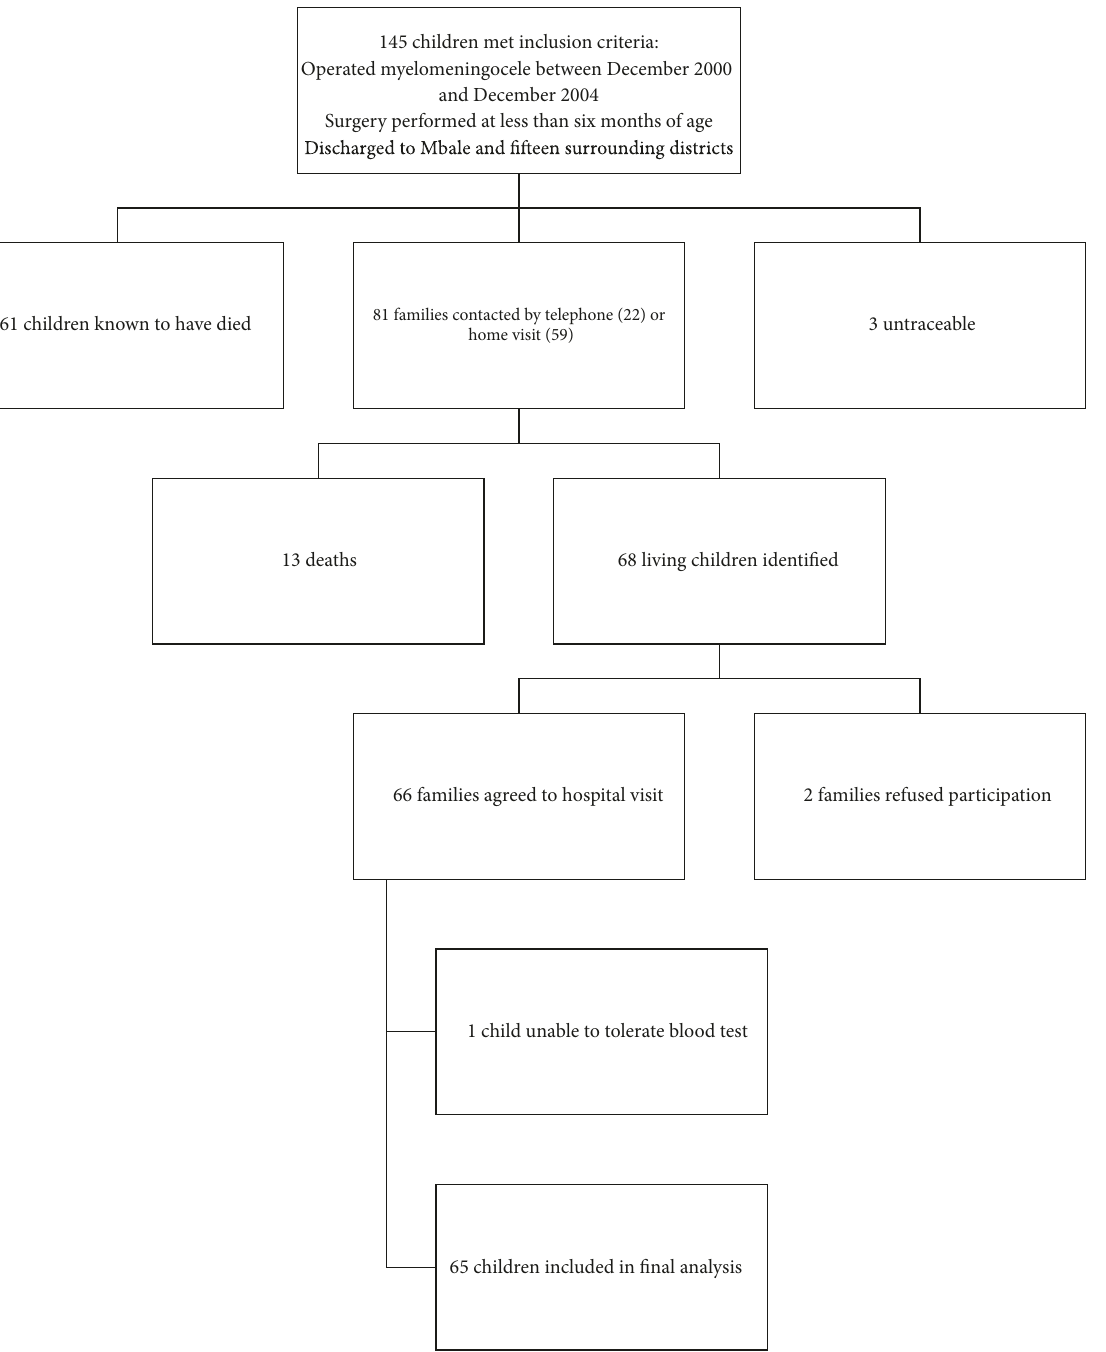
Figure 1: Flow diagram for patient